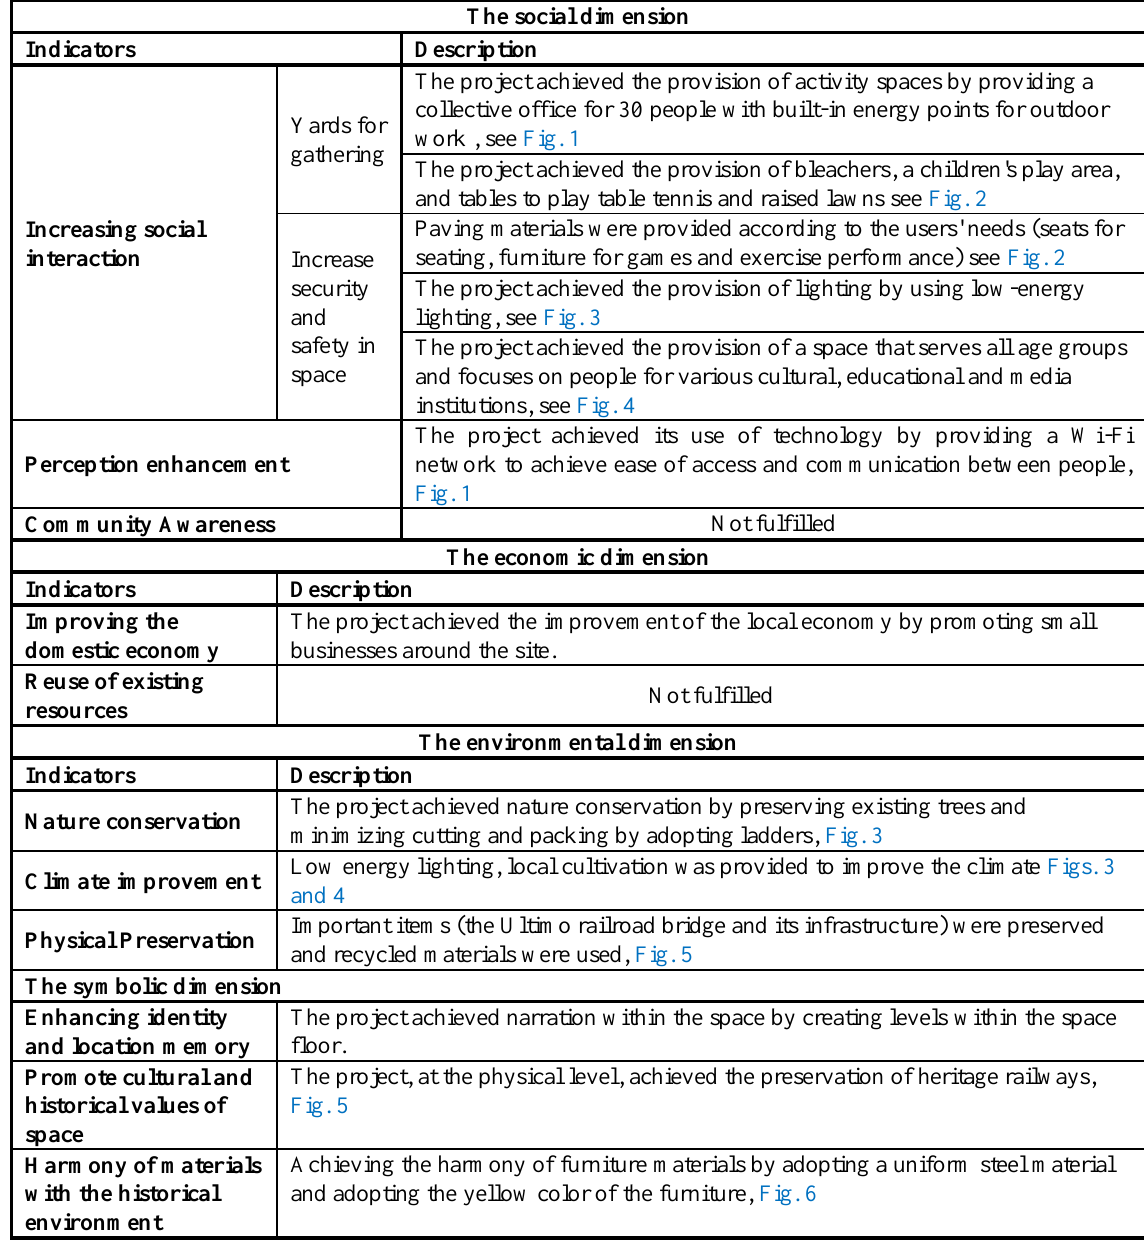
Table 2. The form of measuring verification values for the dimensions of activating landscapes, first case, (prepared by the